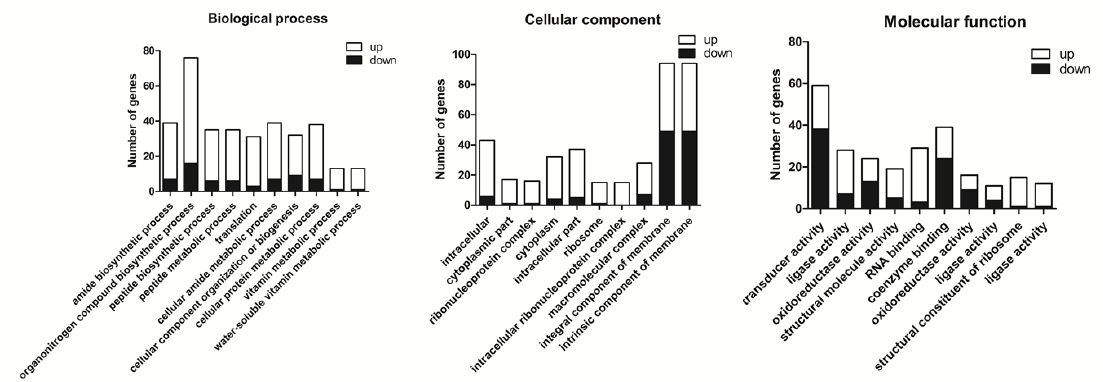
nors (GO:0016614) (Figure S6). Statistics of the first 10 pathway genes enriched in the three parts are shown in Figure 8.